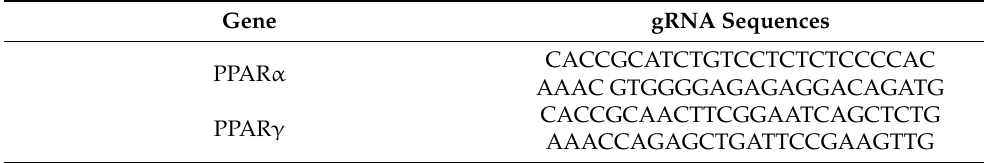
Table 1. The PPAR α / γ gRNA sequences. Gene gRNA Sequences PPAR